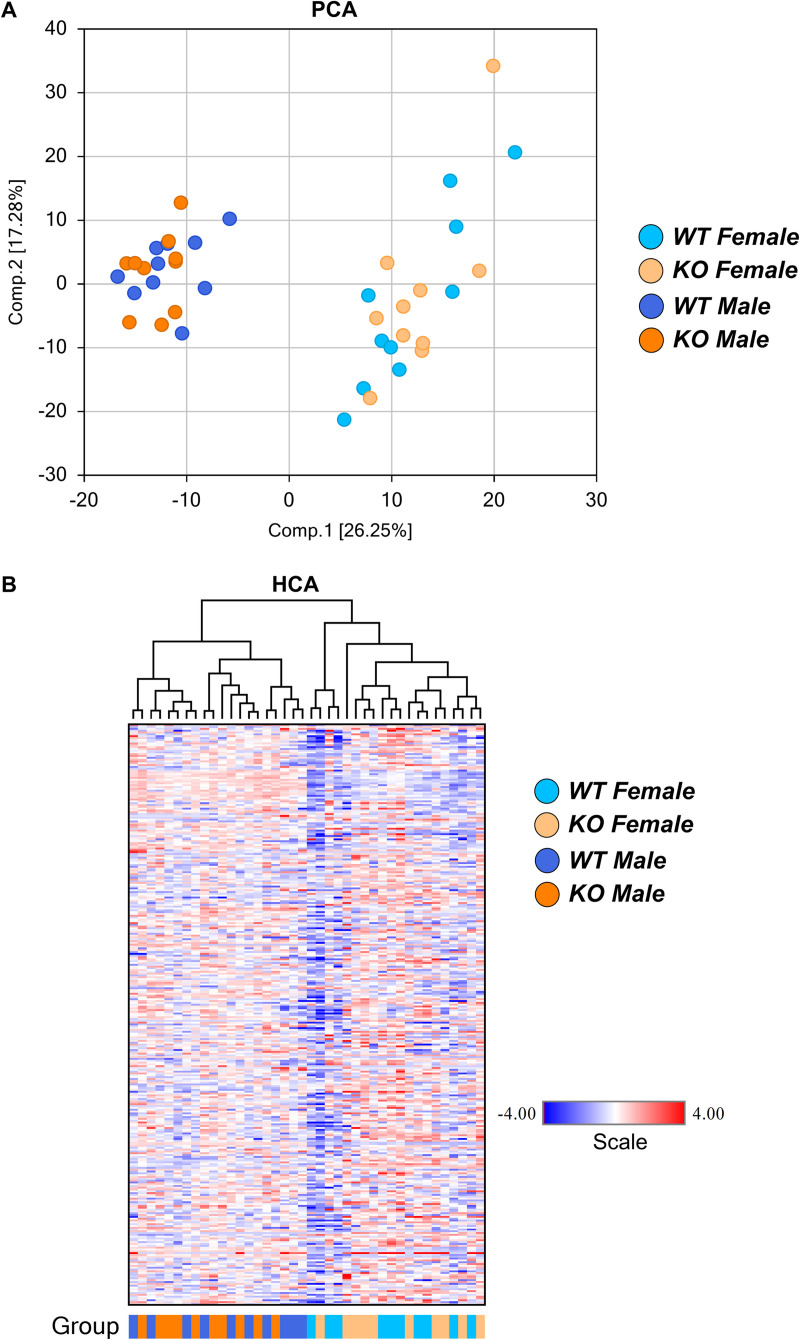
Bioinformatics analysis of metabolites.Fifty to 100 µl of plasma were drawn from mice and subjected to untargeted metabolite analysis by tandem LC/MS. PCA (A) and HCA (B) analysis of AIBP-regulated metabolites in the plasma of AIBP knockout (KO) and control littermate mice.